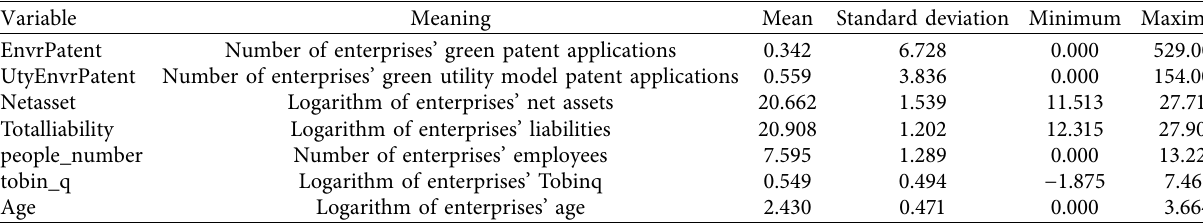
Table 1: Descriptive